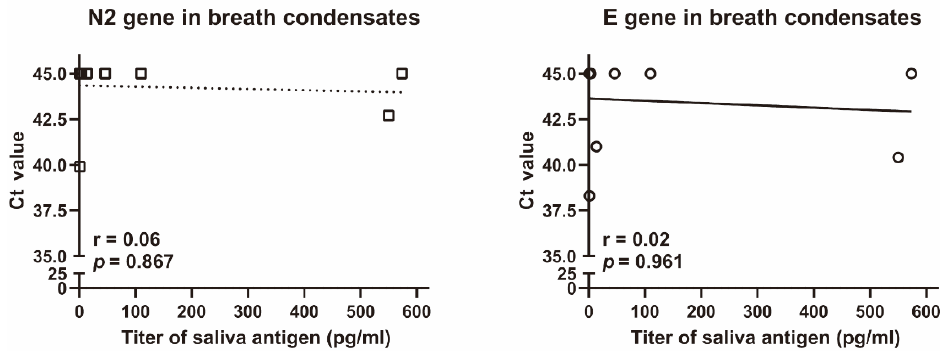
Figure 4. Correlation between saliva antigen and N2 or E genes of SARS-CoV-2 in breath conden- sates. Ct values of N2 and E genes of SARS-CoV-2 in breath condensates were analysed using Xpert ®